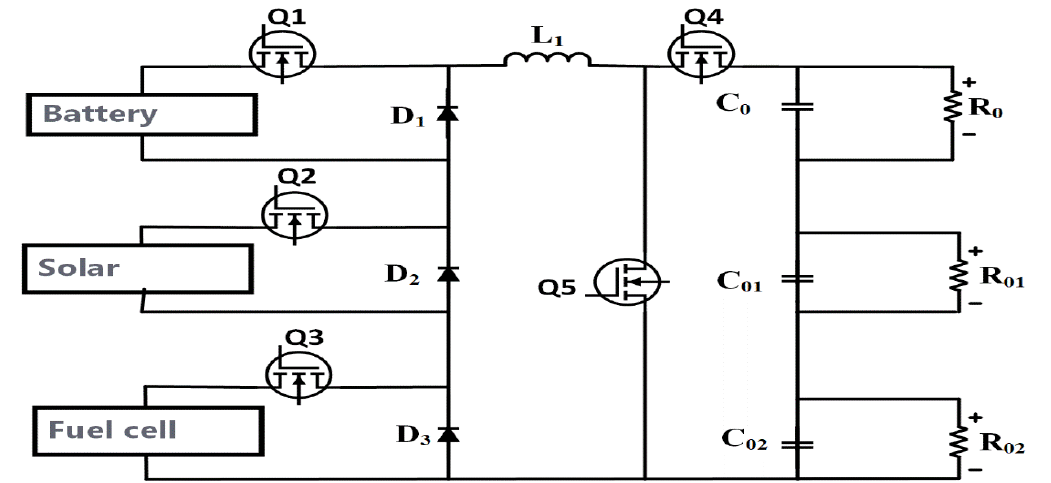
Figure 20. Circuit Diagram of MIMO Converter.